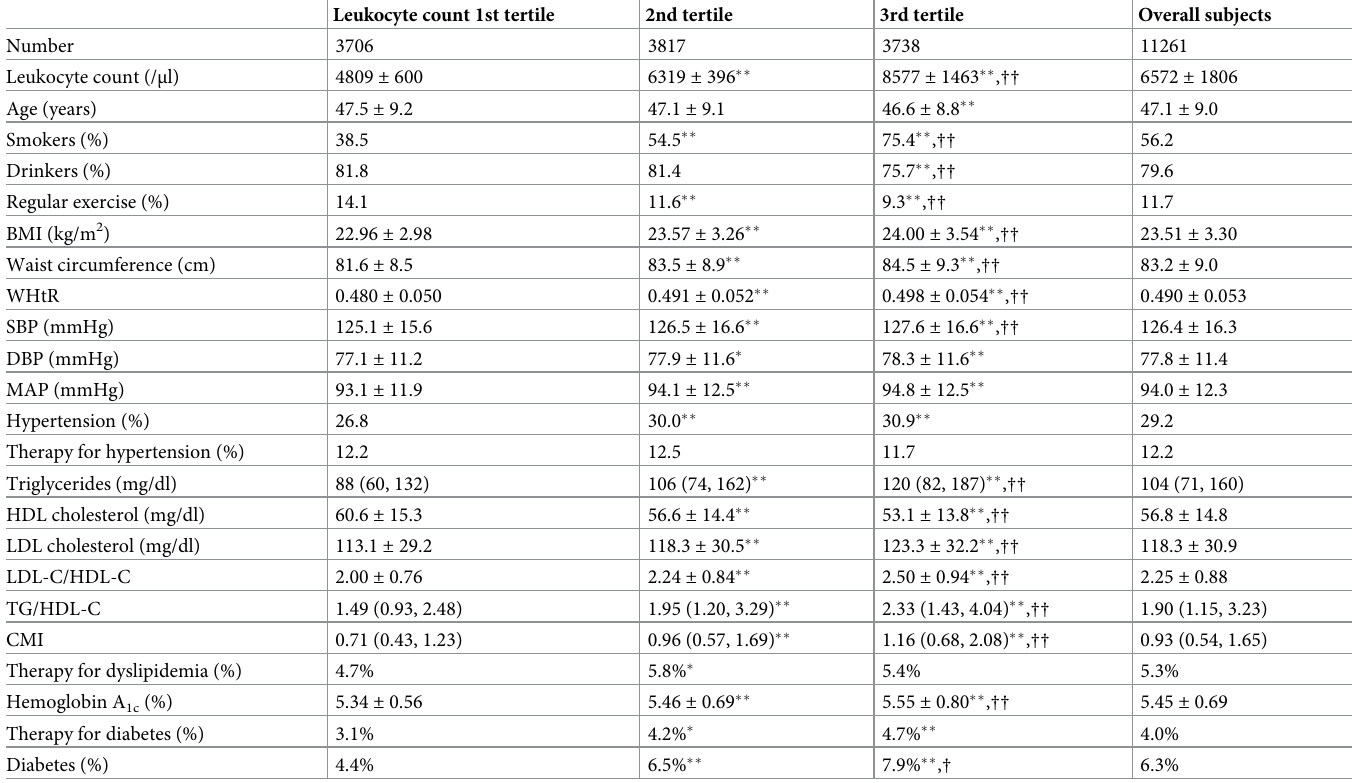
Table 1. Characteristics of overall subjects and subjects in each tertile group of leukocyte count.